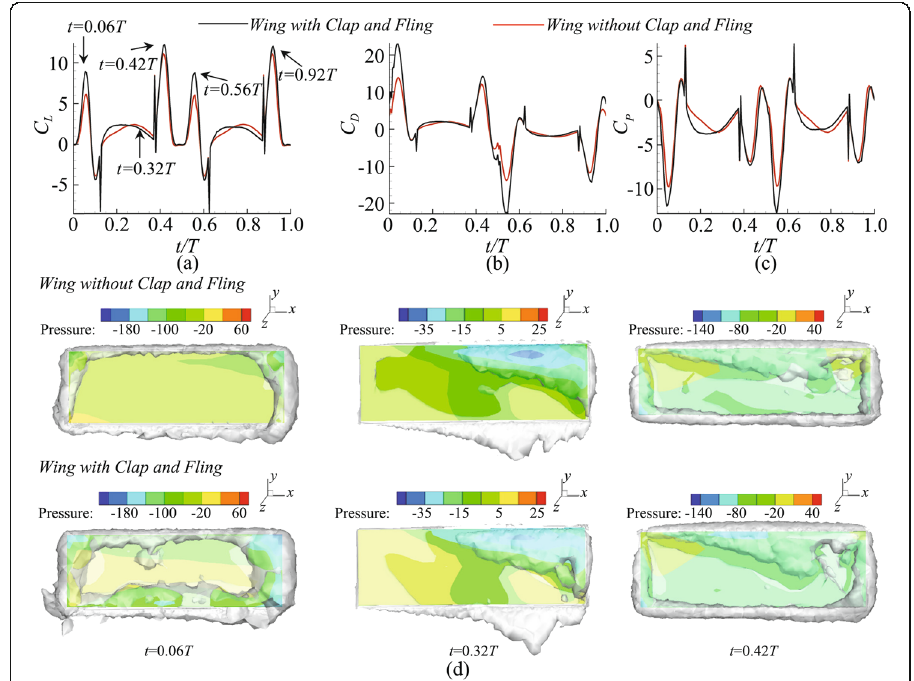
Fig. 7 Aerodynamics, pressure distribution and flow field of the flapping wing with or without clap-and- fling effect in typical time. a - c lift, drag, aerodynamic power coefficient changes during a stroke cycle, d pressure distribution of typical